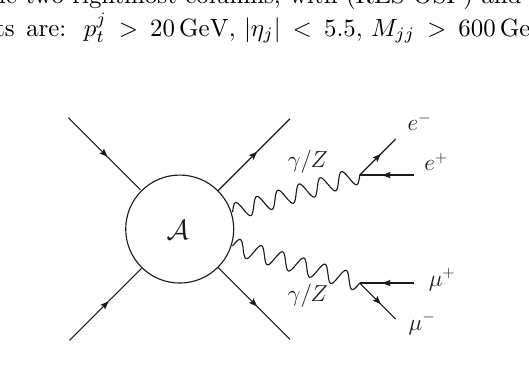
jje + e (cid:0) (cid:22) + (cid:22) (cid:0) !